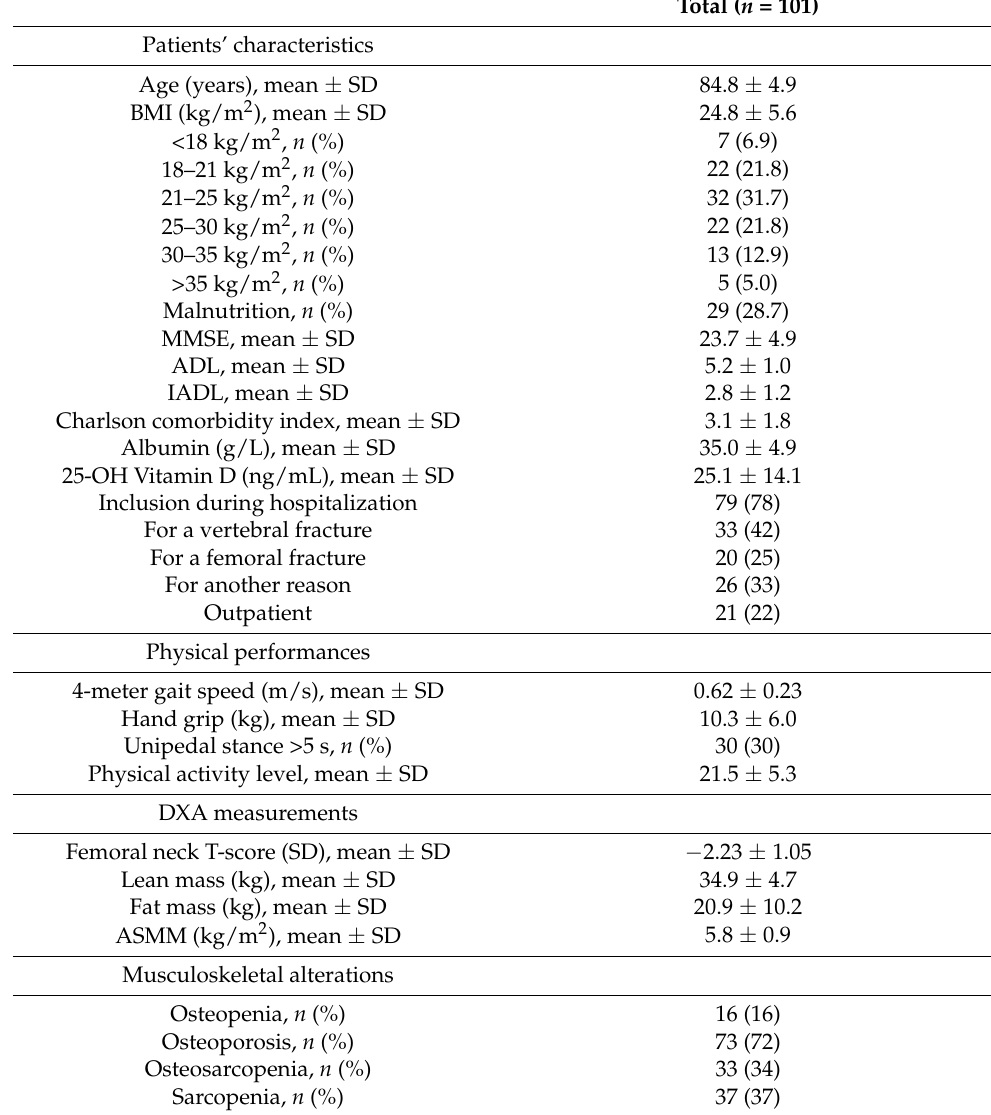
Table 1. Population